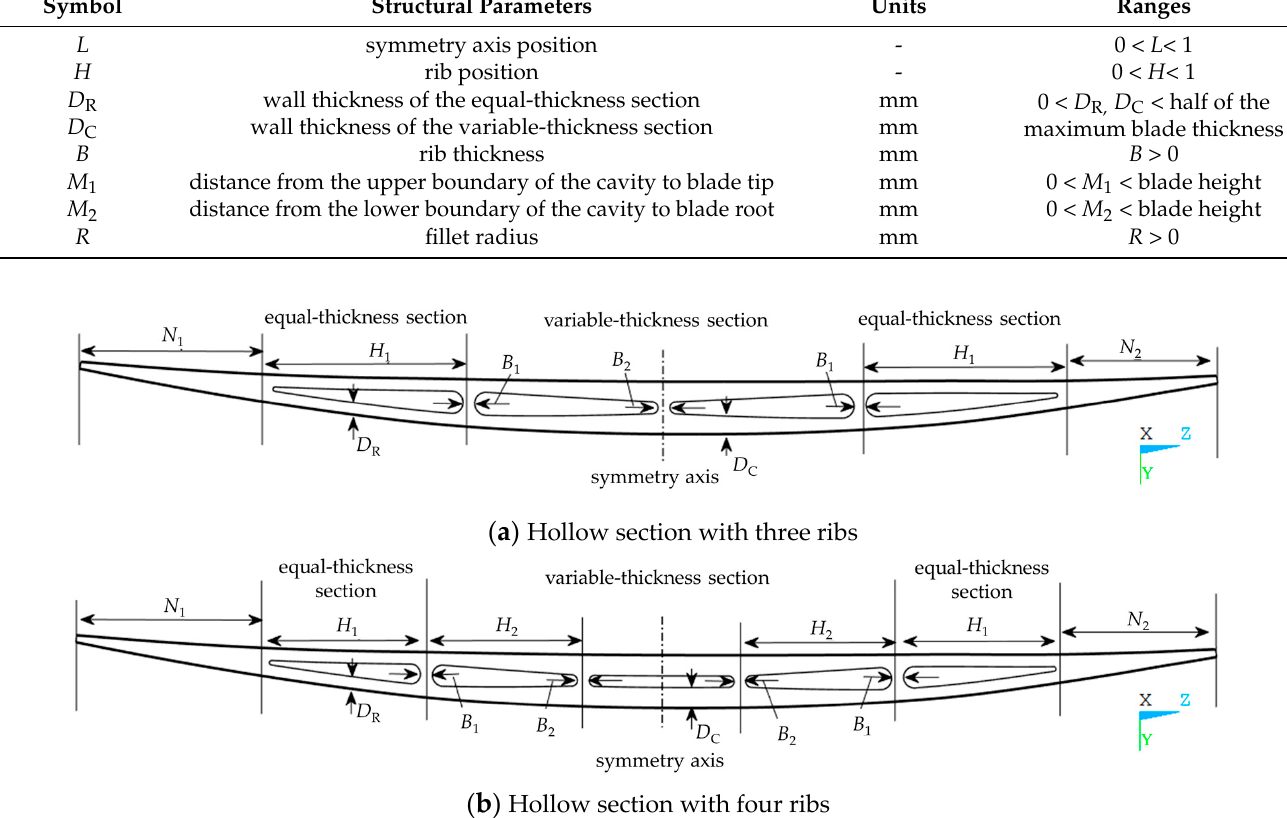
Figure 2. Model parameterization of hollow section. Table 1. Structural parameters of hollow fan blade.